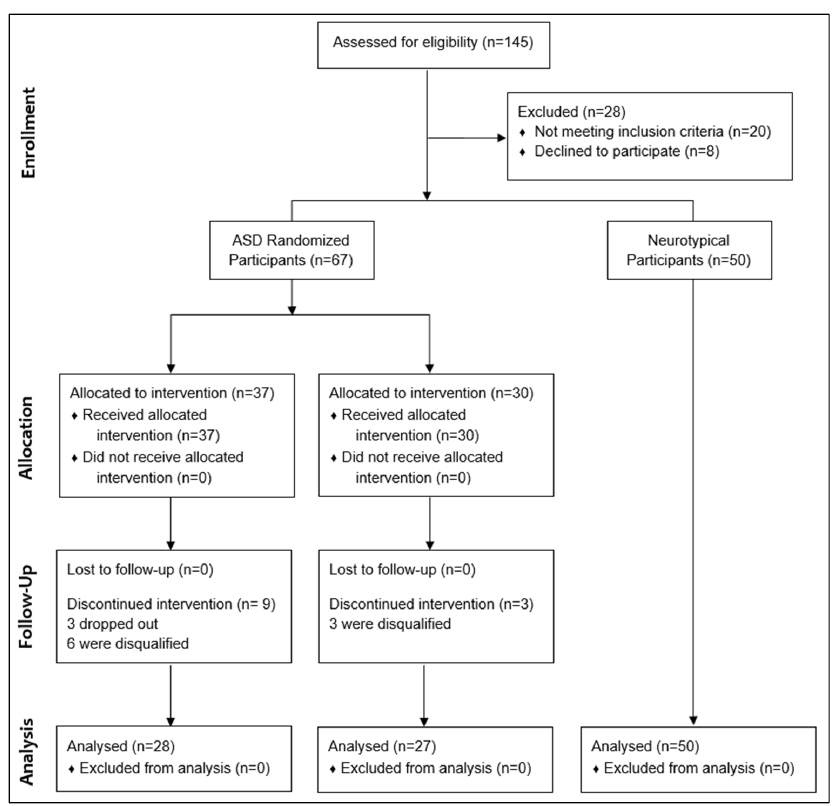
Figure 1. Study Flowchart.